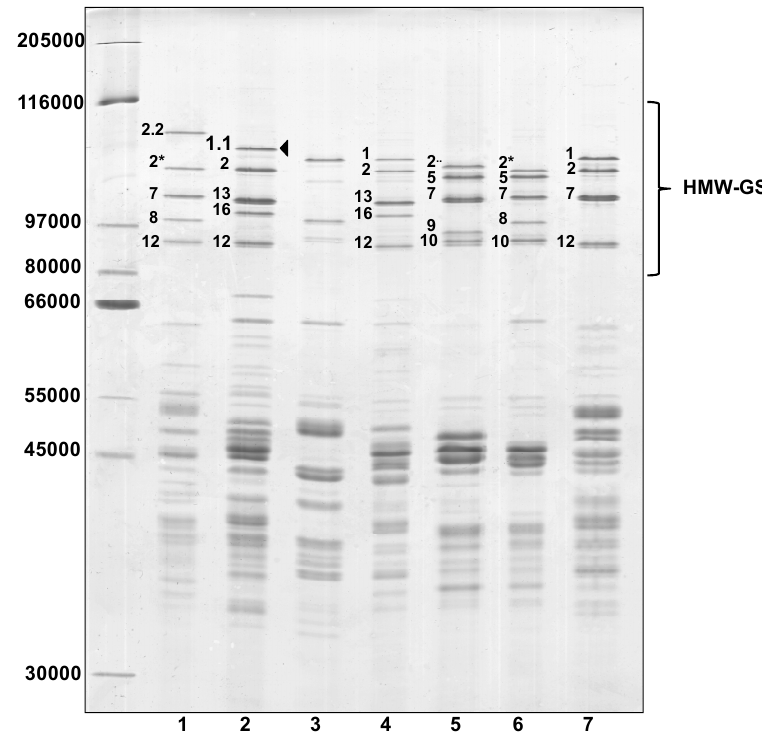
Figure 1. Reduced and alkylated glutenin subunit patterns of selected bread wheat accessions analyzed by SDS–PAGE using a 12% gel for both high molecular weight-glutenin subunits (HMW-GS) and low molecular weight-glutenin subunits (LMW-GS). The HMW-GS are labeled according to the nomenclature of Payne and Lawrence [18]. Lane 1, ‘Fukihokomugi’; lane 2, ‘Barbela 28’; lane 3, ‘PI 355’; lane 4, ‘Carala’; lane 5, ‘211 12